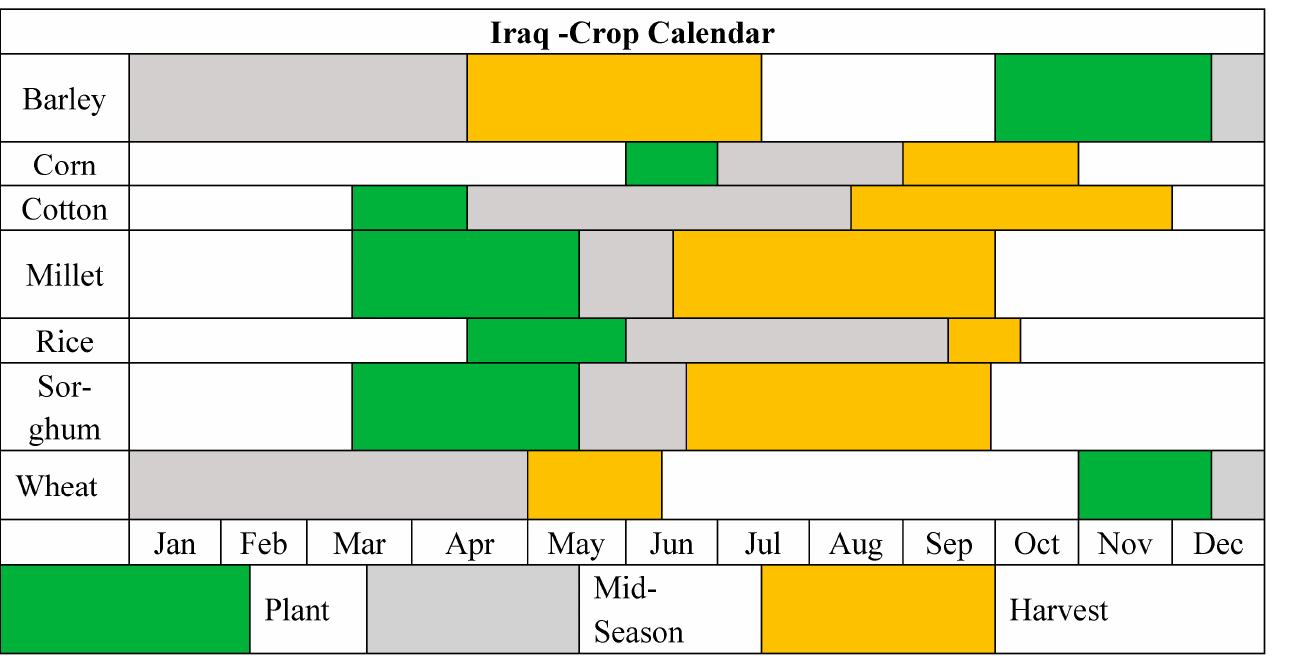
Figure 3. Flowchart of the methodology adopted in this study.